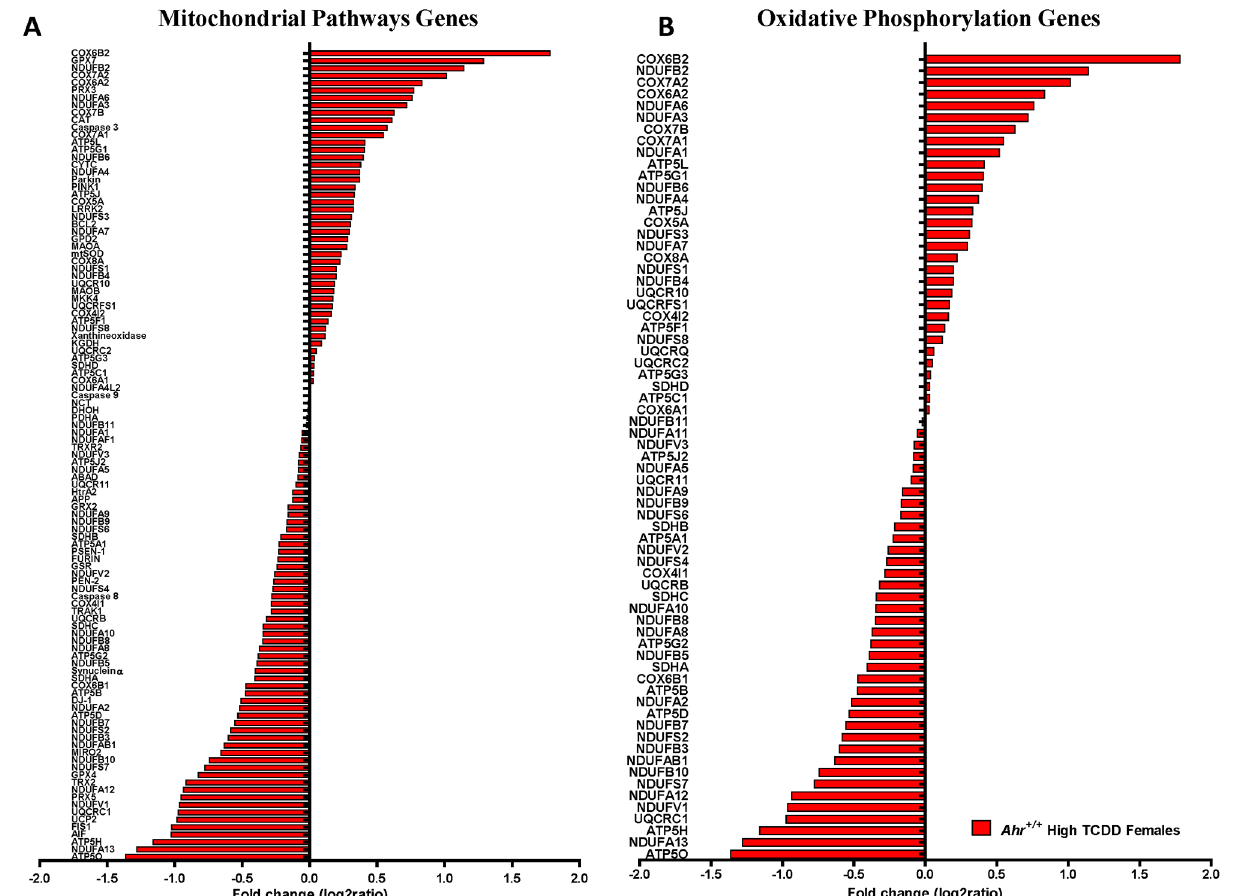
Fig 5. Mitochondrial dysfunction and altered oxidative phosphorylation genes in the adult heart as a result of in utero disruption of AHR signaling. Fold change of expression of significantly altered genes in (A) functional mitochondrial pathways and (B) oxidative phosphorylation (B) at 10 months of age (PND 300) of high dose TCDD-exposed Ahr +/+ female adult